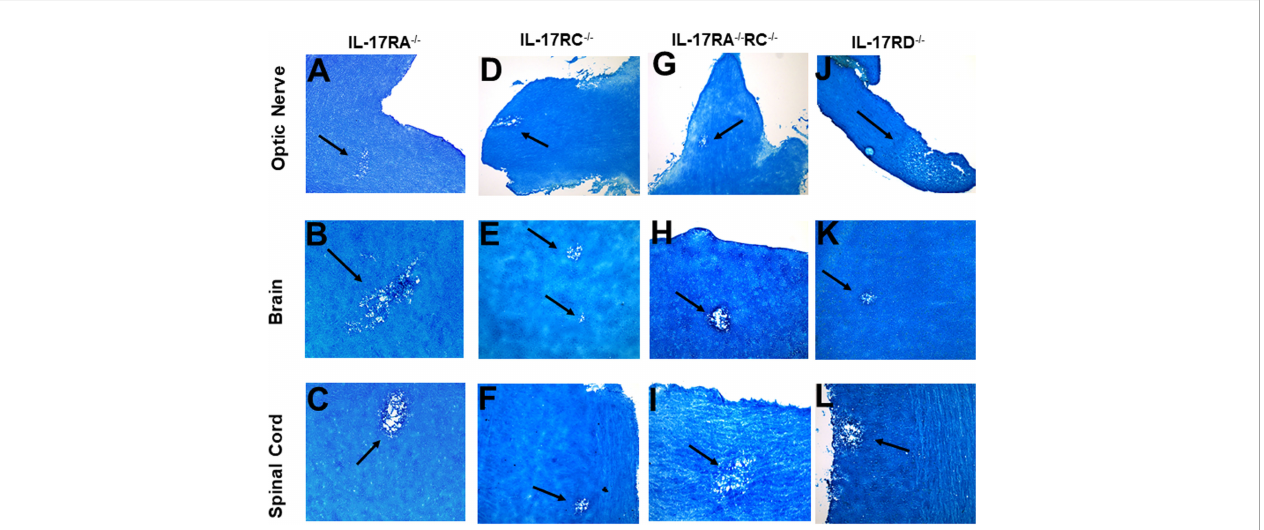
FIGURE 5 Role of IL-17 receptors in HSV-IL-2 induced CNS demyelination. Five female IL-17RA -/- (A, B, C) , IL-17RC -/- (D, E, F) , IL-17RA -/- RC -/- (G, H, I) and IL- 17RD -/- (J, K, L) mice were infected ocularly with 2 X10 5 pfu/eye of HSV-IL-2 virus. On day 14 PI, optic nerves (A, D, G, J) , brain (B, E, H, K) , and spinal cord (C, F, I, L) were collected, fi xed, sectioned, and stained with LFB. Representative photomicrographs are shown. Arrows indicate areas of demyelination. x10 objective lens was used (100x